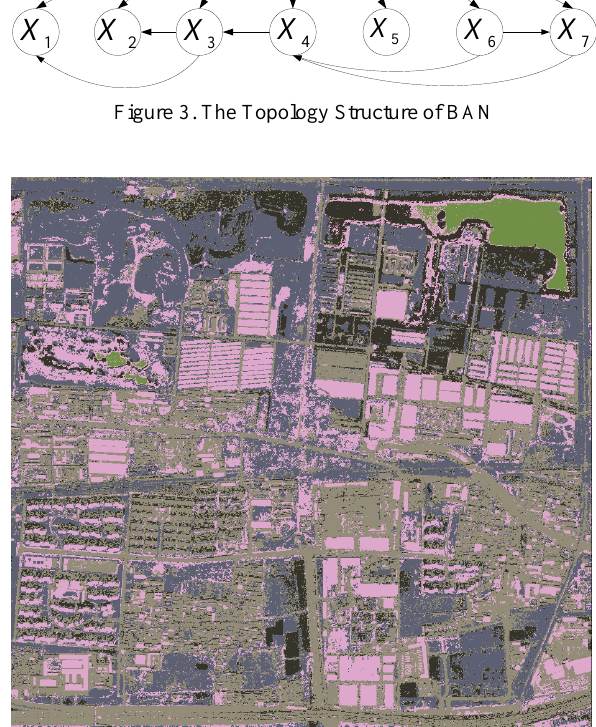
Figure 4. Classification Image Based On the